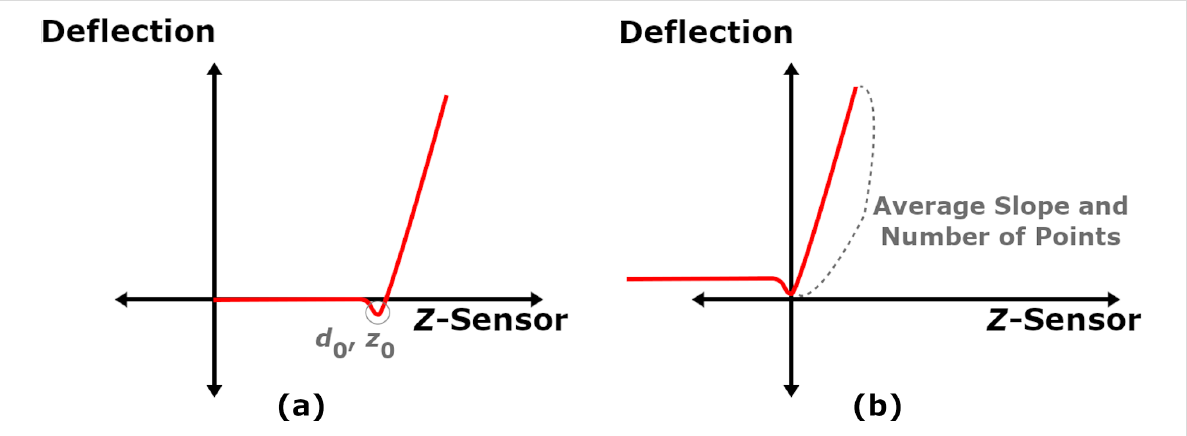
Figure 3: (a) AFM-SFS data corrected for an initial deflection offset; (b) Correction of the Z -Sensor dataset such that the minimum cantilever position occurs at the origin.